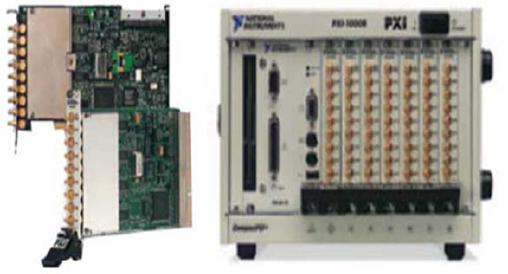
Figure 4. National Instrument Board and Data Acquisition Equipment.